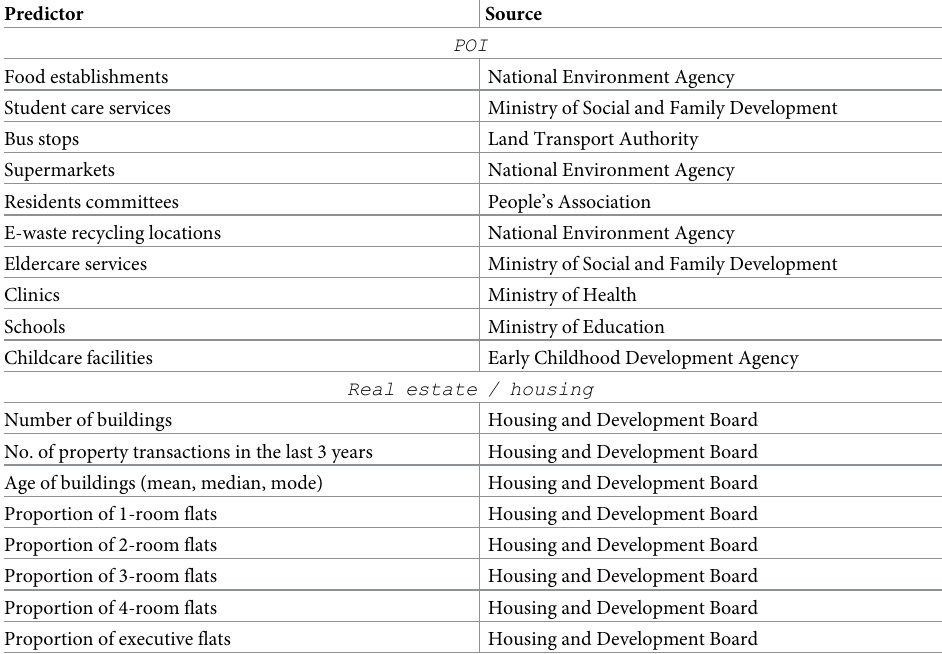
Table 1. An overview of the predictors. For each subzone, the density of each amenity has been computed.